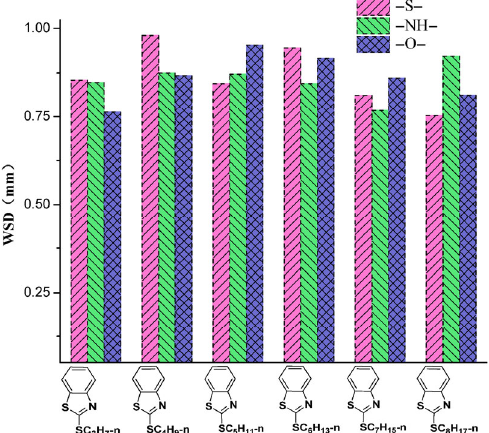
Fig. 16 The wear scar width of each steel ball when lubricating with thiobenzothiazole compounds and their isosteres in TMPTO.